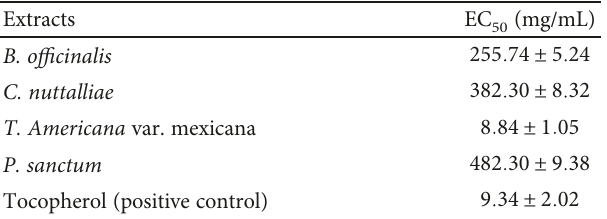
Figure 1: Glucose levels, basal and 4 hours after the administration of the extracts under study at doses of 250 and 500 mg/kg. Values are expressed as mean ± SD . Table 2: DPPH radical scavenging activities of the extracts. Values are expressed as mean ± SD .